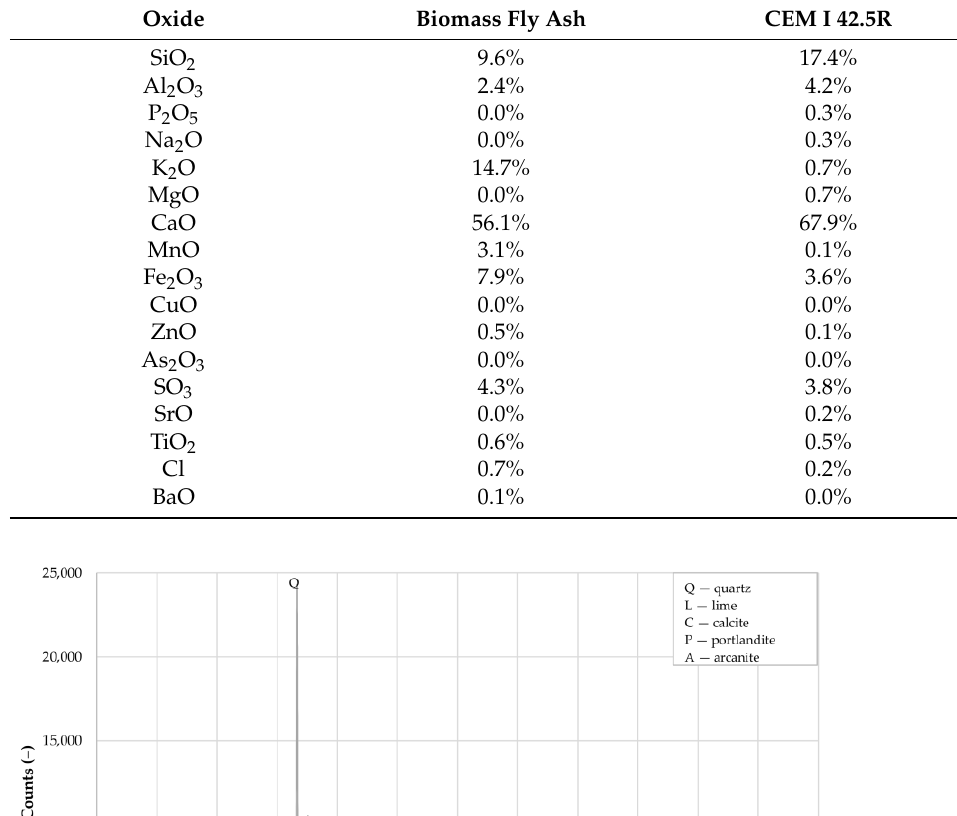
Table 1. Chemical oxide composition of biomass fly ash before activation and CEM I 42.5 R cement used in the study.